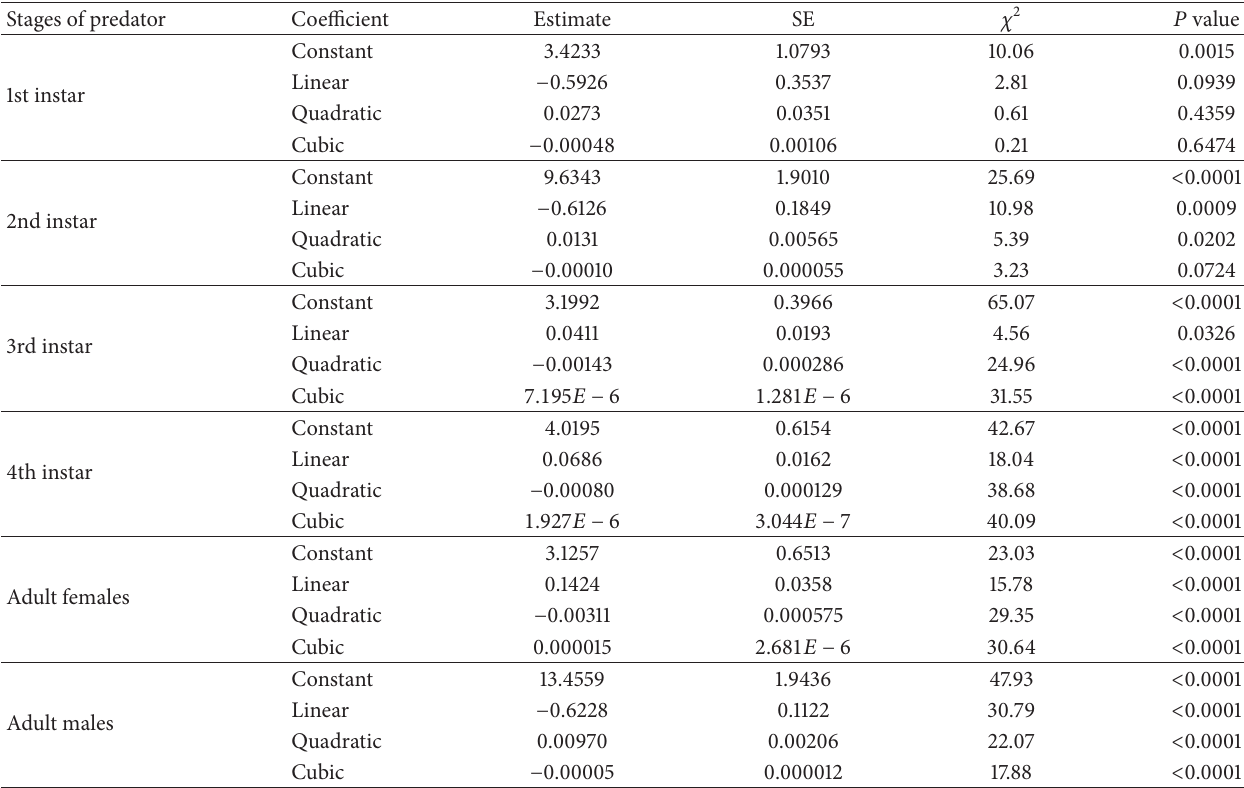
Table 1: Results of logistic regression analysis of the proportion of N. viridis consumed by different stages of N. arcuatus as a function of initial prey density.